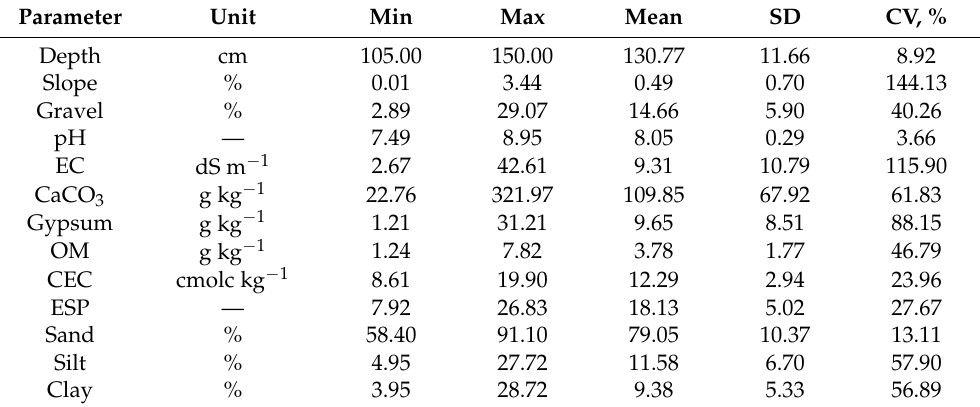
Table 3. Descriptive statistics of soil properties of the studied area.